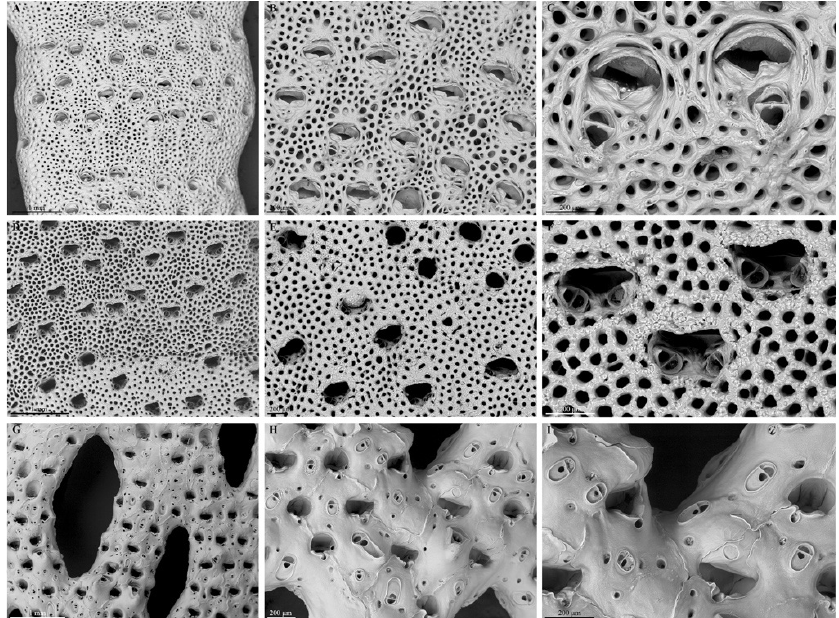
Figure 4. Scanning electron micrographs (SEM images) of the target species. ( A – C ) Cellarinella nutti : ( A ) portion of the branch including one year of growth; ( B ) detail of zooids and immersed